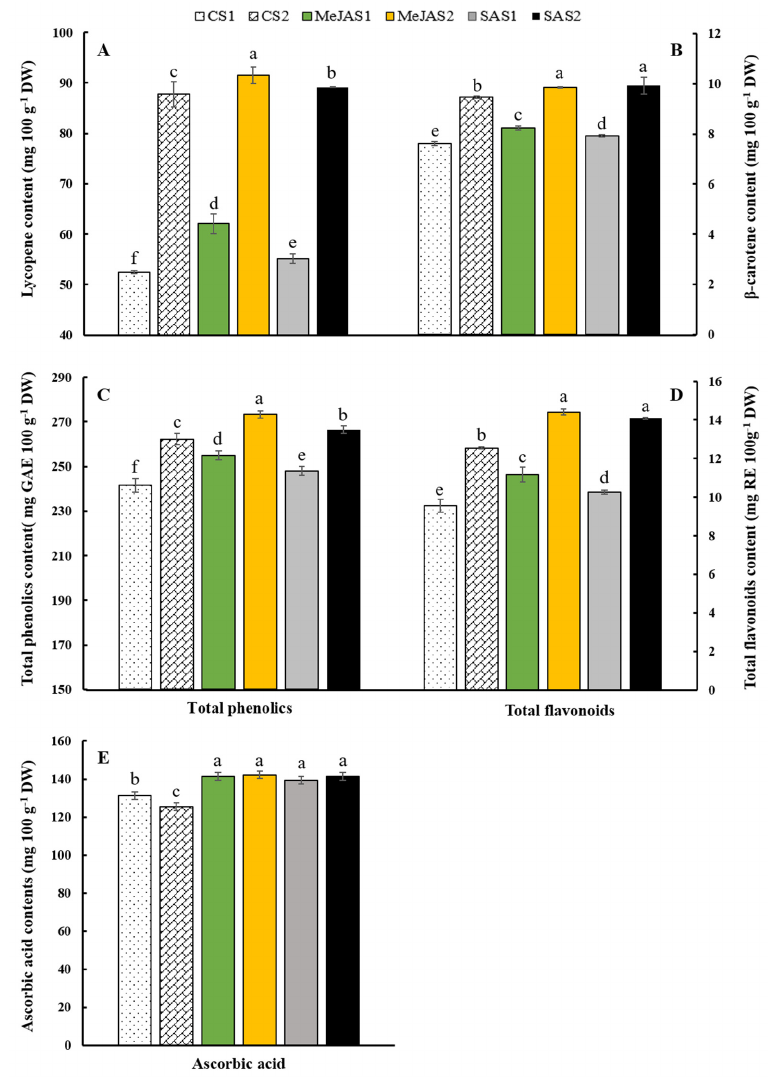
Figure 2. Lycopene ( A ), β -carotene ( B ), total phenolics ( C ), total flavonoids ( D ), and vitamin C ( E ) contents of ‘Kumato’ tomato cultivar in the control and treatment (0.25 mM MeJA and 0.5 mM SA) groups at two maturity stages. The bars with different letters indicate a significant difference ( p < 0.05) between treatments. The vertical bars represent the standard error of the means ( n = 5). CS1, CS2, MeJAS1, MeJAS2, SAS1, and SAS2 represent control, preharvest MeJA and SA treatments at S1 and S2 maturity stages, respectively.